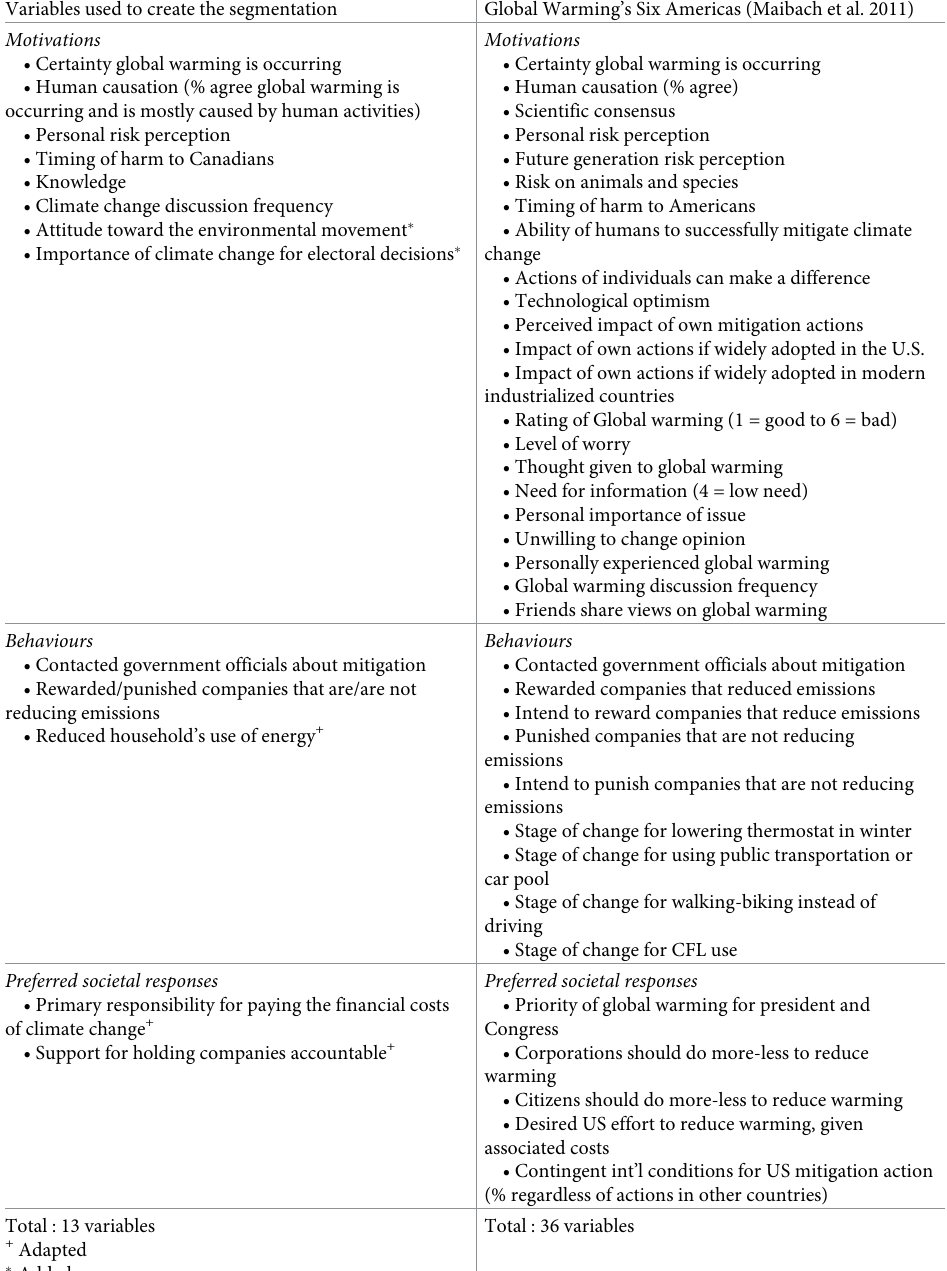
Table 1. Variables used to create the segmentation (vs. items used in Global Warming’s Six